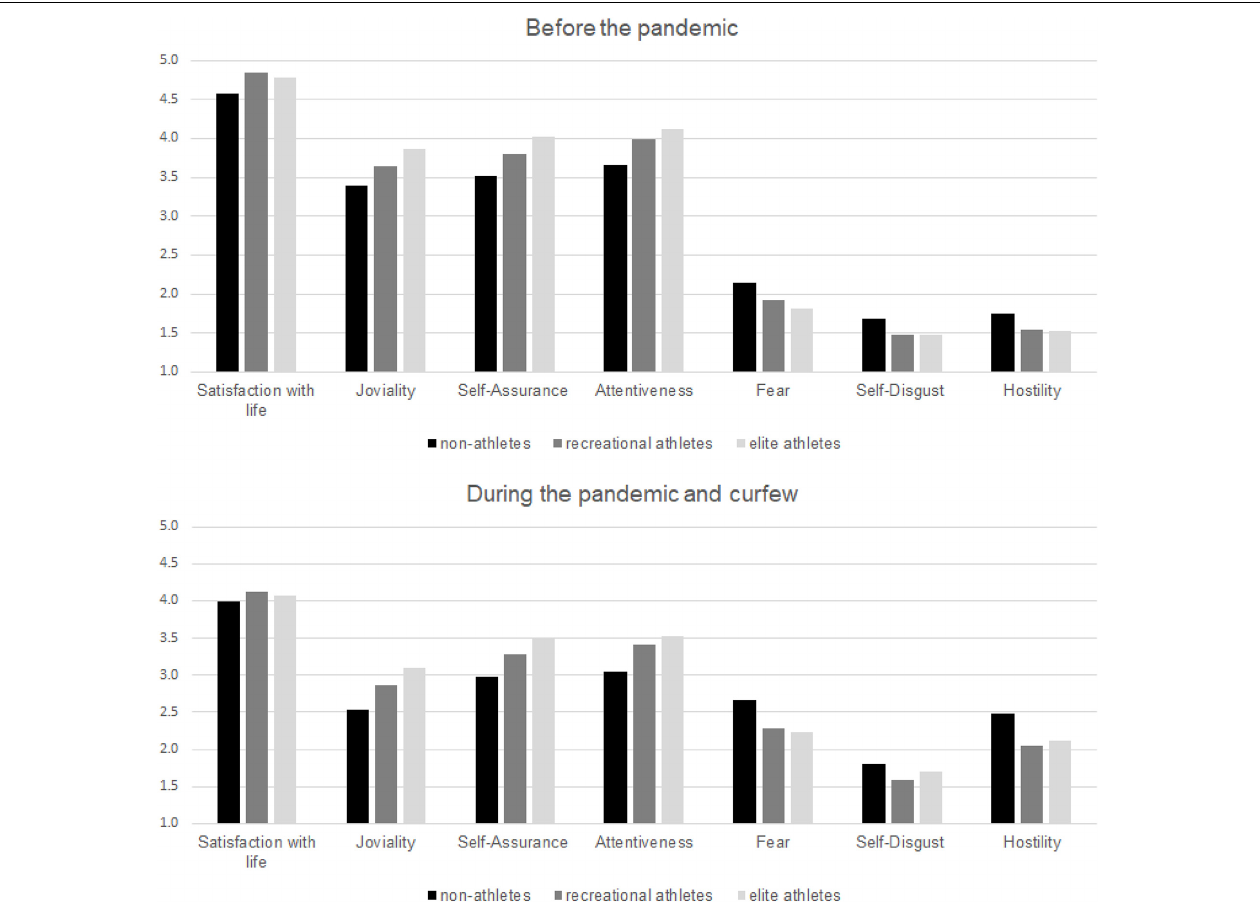
FIGURE 2 | Well-being domains before (top) and during the emergency state and curfew (bottom) in non-athletes, recreational athletes, and elite athletes ( N = 398).